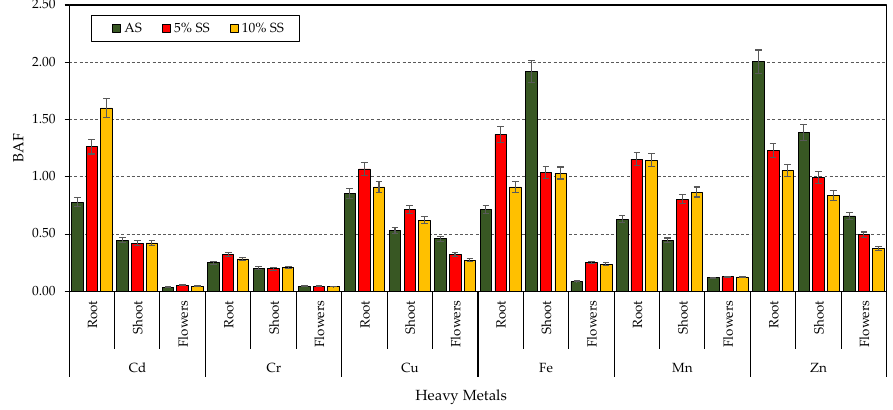
Figure 1. Bioaccumulation factor (BAF) of six heavy metals in di ff erent plant parts of marigold cultivated in di ff erent treatments (AS: arable soil as control, SS: sewage sludge).